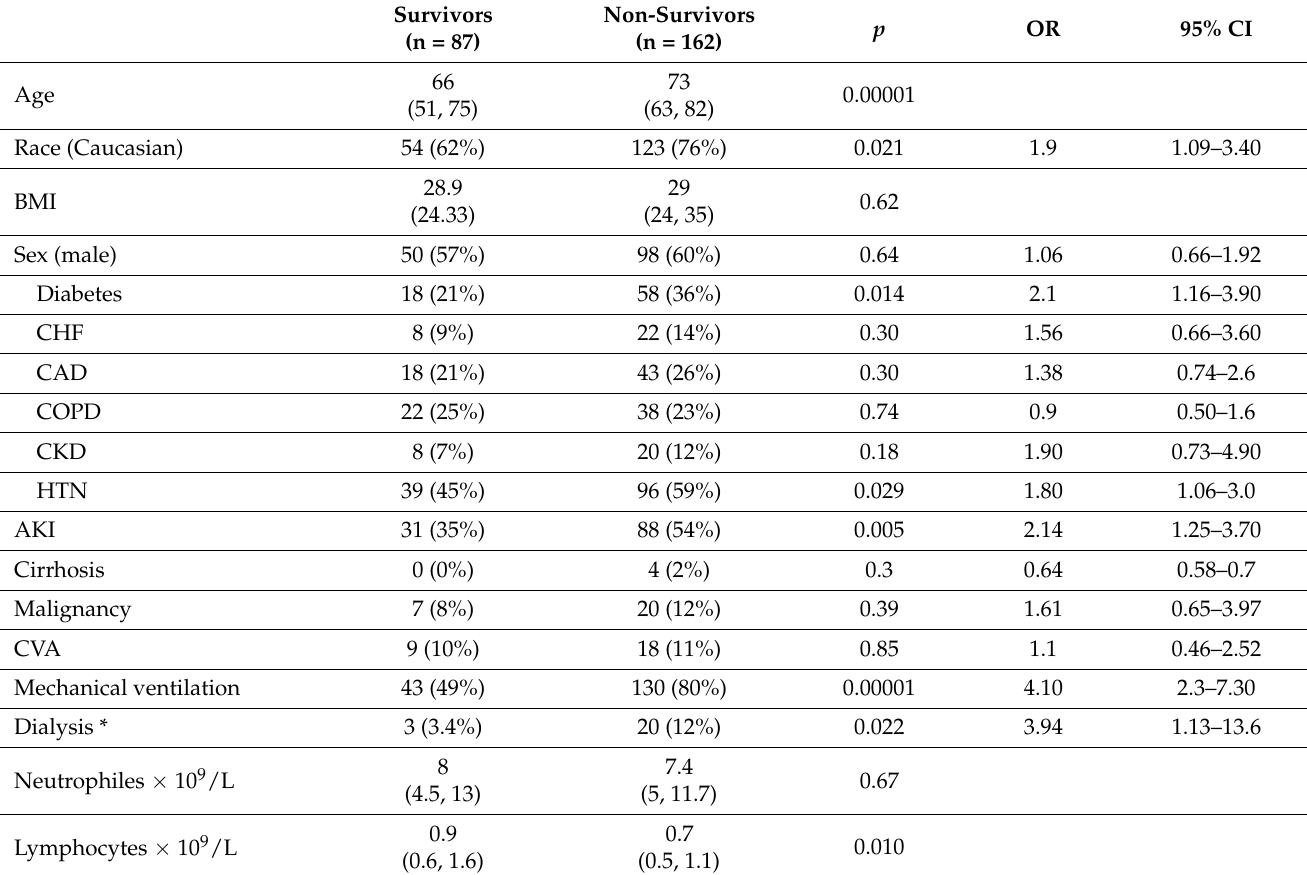
Figure 2. Forest plot depicting the impact of the indicated risk factors on the odds ratio (OR) for developing AKI as determined by logistic regression with stepwise forward variable selection. For continuous variables, the odds ratio (OR) represents the relative amount by which the odds ratio for the outcome variable increases or decreases when the independent variable is increased by exactly one unit. Table 5. COVID-19 ICU patients: characteristics of survivors and Table 4. Multivariate analysis of risk factors for AKI.